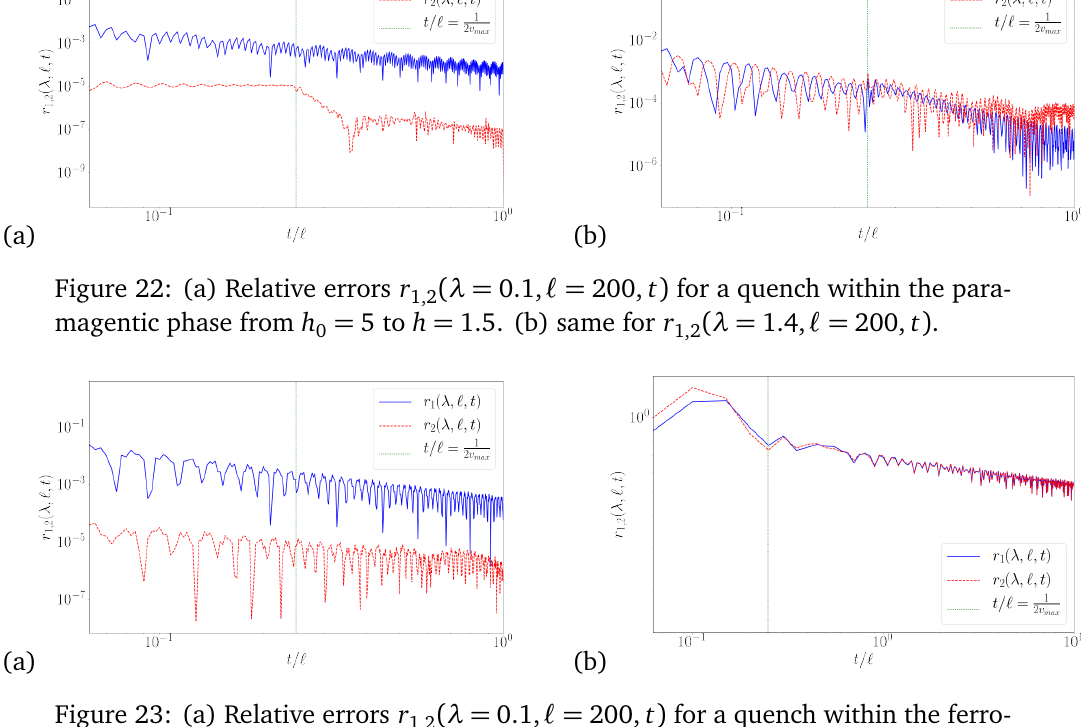
Figure 23: (a) Relative errors r magnetic phase from h